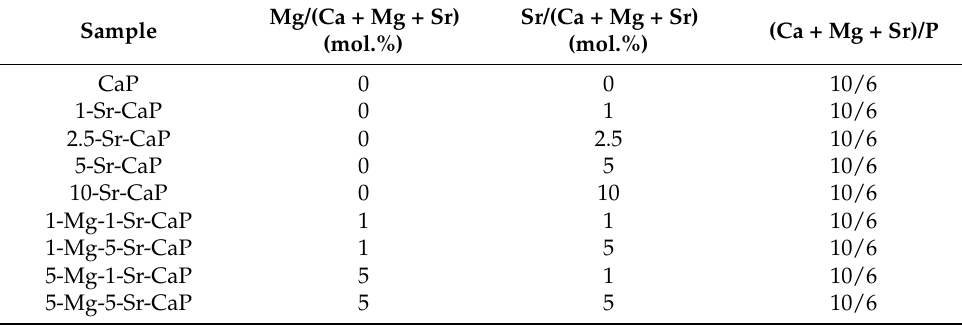
Table 1. Nominal composition and denomination of prepared